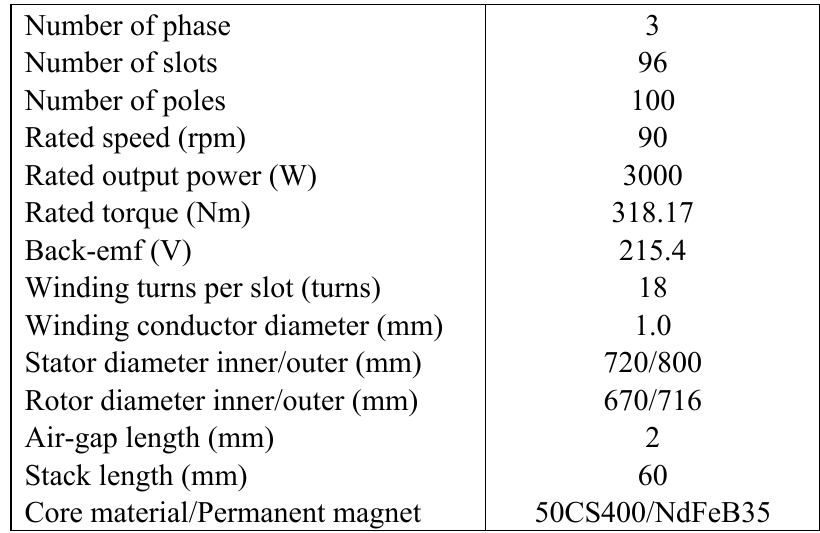
Table 2. Dimensions of initially designed wind